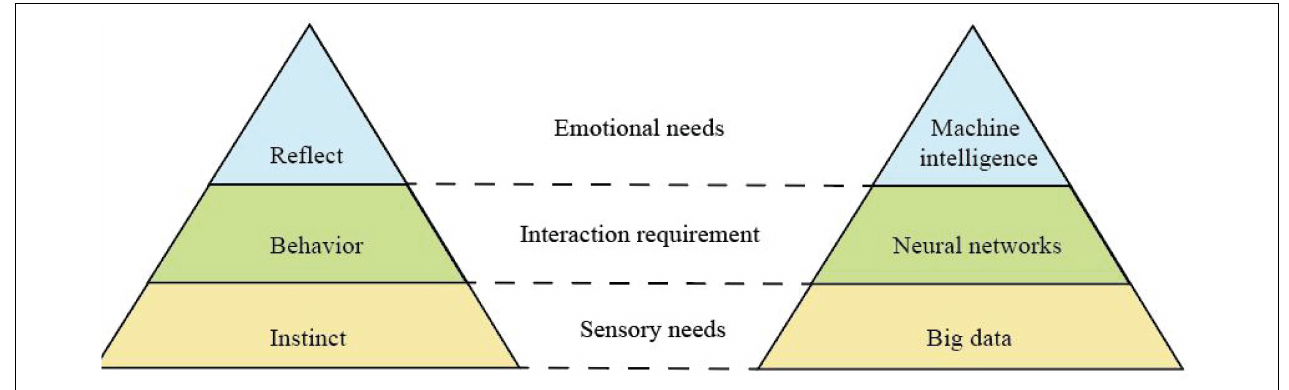
FIGURE 4 | Human behavior model and proposed machine experience model.